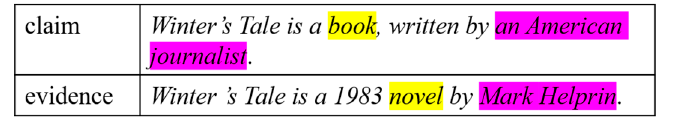
Figure 1. Error case of advanced fact verification (FV) approaches only based on pre-training language models.